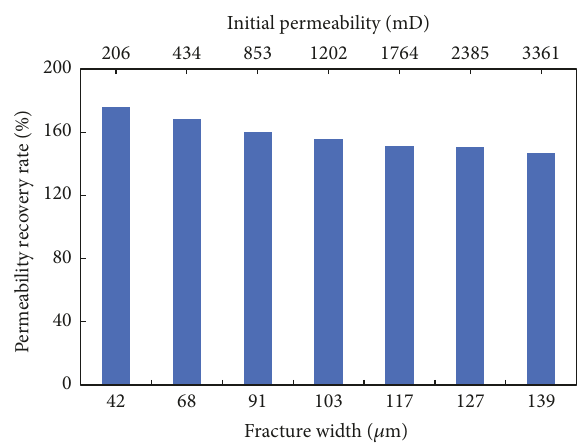
Figure 9: Permeability enhancement after acidizing treatment in undamaged core samples (core samples #14–#20).